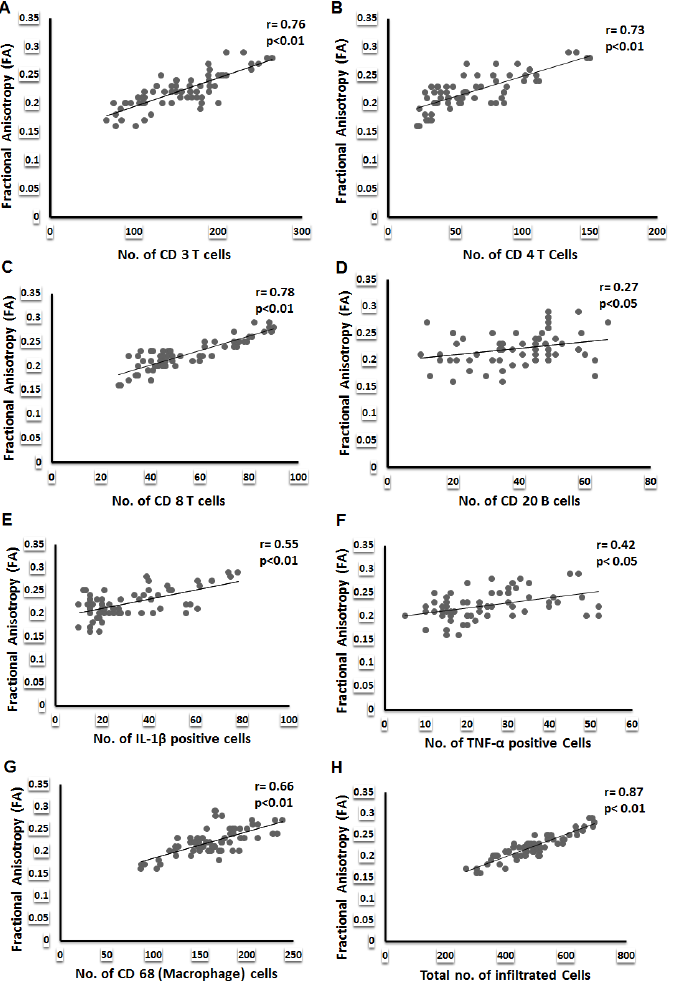
Figure 3. Correlation of inflammatory cell infiltration with fractional anisotropy. Spearman’s correla- tion scatter plots represent the correlation between ( A ) FA and CD3, ( B ) CD4, ( C ) CD8, ( D ) CD20, ( E ) IL-1 β positive cells, ( F ) TNF- α positive cells, ( G ) CD68 and ( H ) total number of inflammatory cells in the synovium. In the synovial fluid, DTI parameters; FA, MD, and CL significantly correlated with the synovial fluid proinflammatory cytokines (Table 5) in all patients and in different groups also. In contrast to DTI and DCE parameters, post-contrast intensity (parameter of conventional MRI) did not correlate with any of the IHC parameters of inflammation ei- ther in the synovium or synovial fluid (except SF IL- 1β).